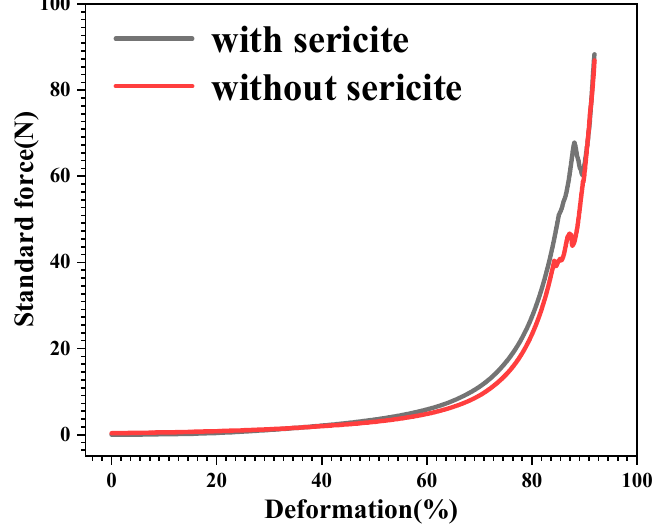
Figure 3. Compressibility test of plugging agent.